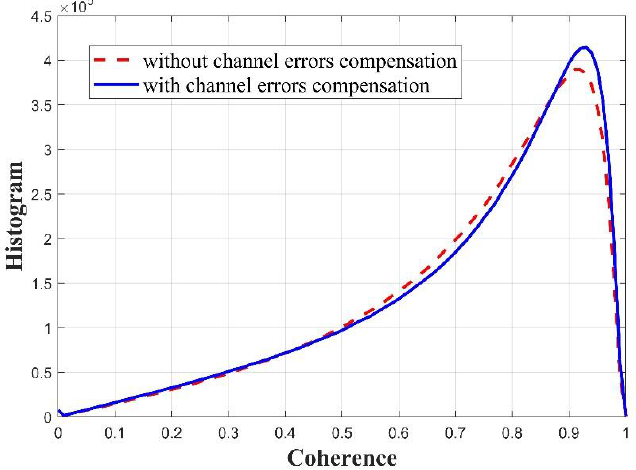
Figure 12. Coherence histograms without/with channel errors ’ compensation.